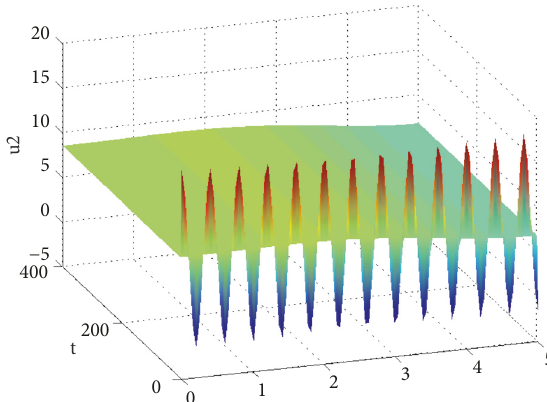
Figure 2: Dynamic behavior of solution 𝑢 2 .